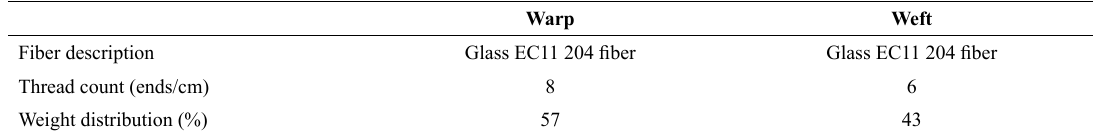
Table 2. Characteristics of the glass fabrics used.